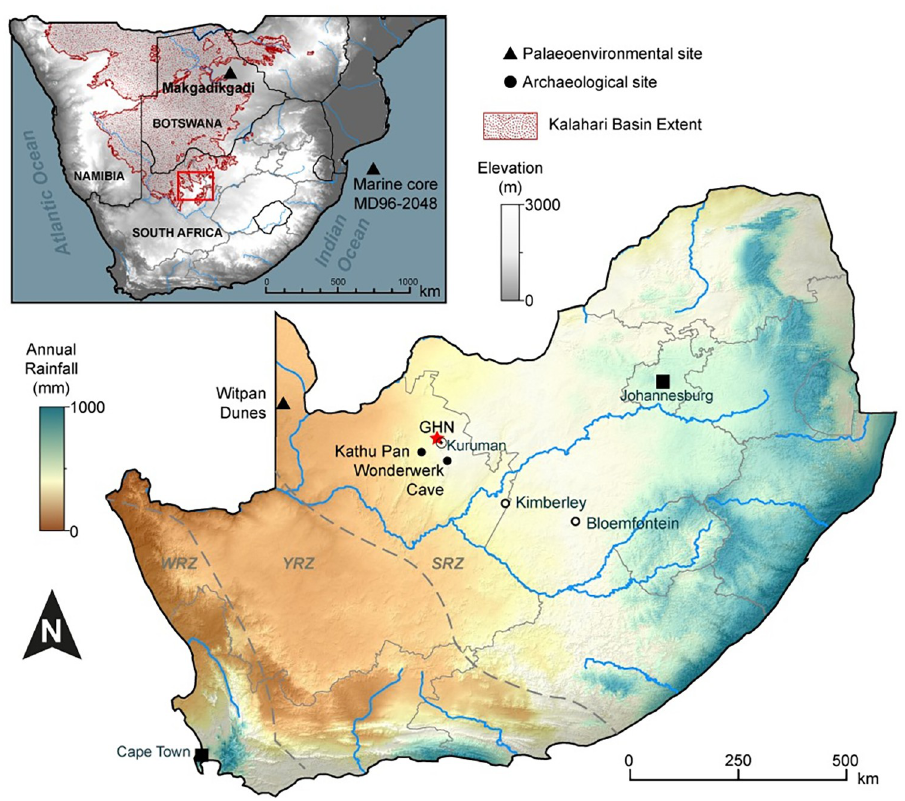
Fig 1. Map of South Africa with the location of Ga-Mohana Hill (GHN) and key palaeoenvironmental and middle stone age sites discussed in the text. Dashed lines demarcate summer and winter rainfall zone boundaries (SRZ, WRZ), middle area experiences year-round rainfall (YRZ). Inset map shows the approximate extent of the Kalahari Basin in southern Africa and the location of the region of interest in relation to it. Figure produced in ArcGIS 10 from multiple open source datasets: Kalahari Basin extent from SASSCAL Open Access Data Centre [32]; Digital Elevation Model obtained from USGS Earth Explorer [33]; annual rainfall data from WorldClim 2 [34] and river centrelines accessed from Natural Earth vector data